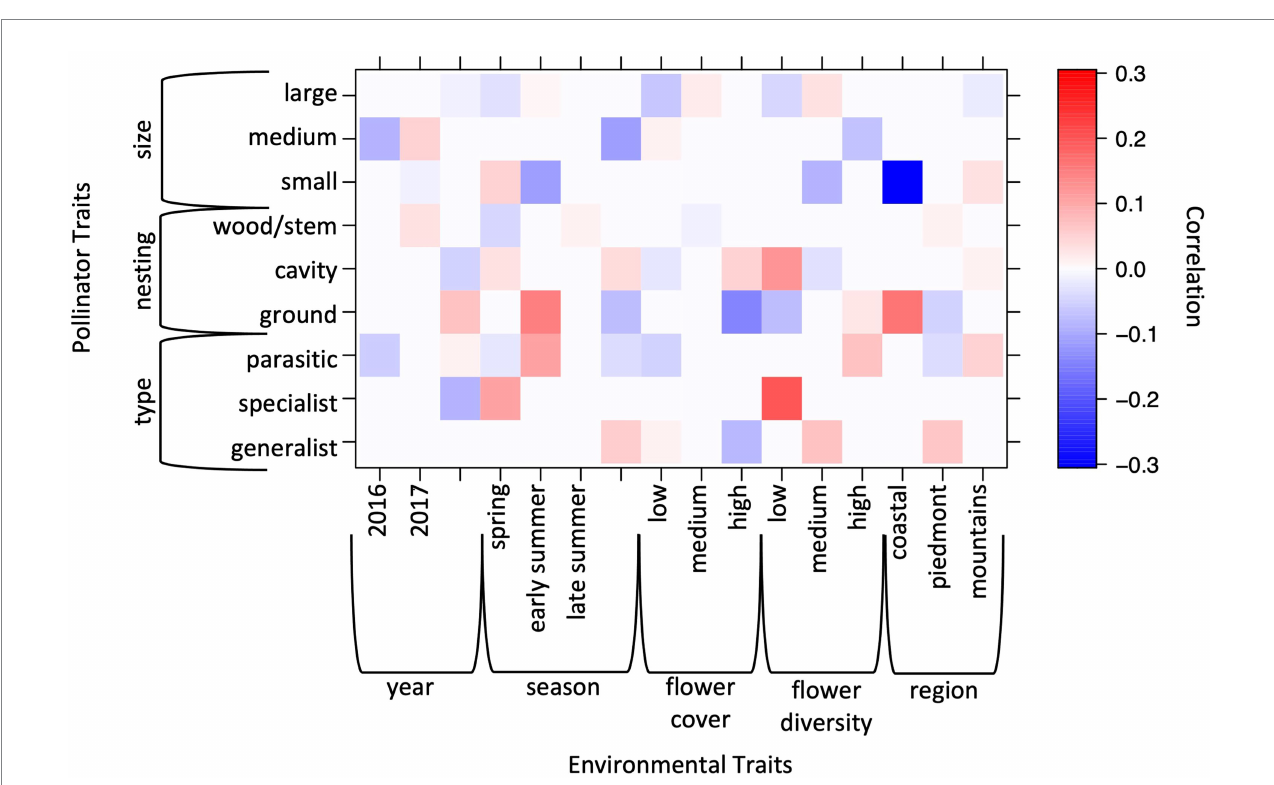
FIGURE 3 Output from fourth corner analysis showing correlations between habitat characteristics and bee functional traits. Positive correlations are shown in red negative correlations are shown in blue. Larger numbers show stronger correlations.